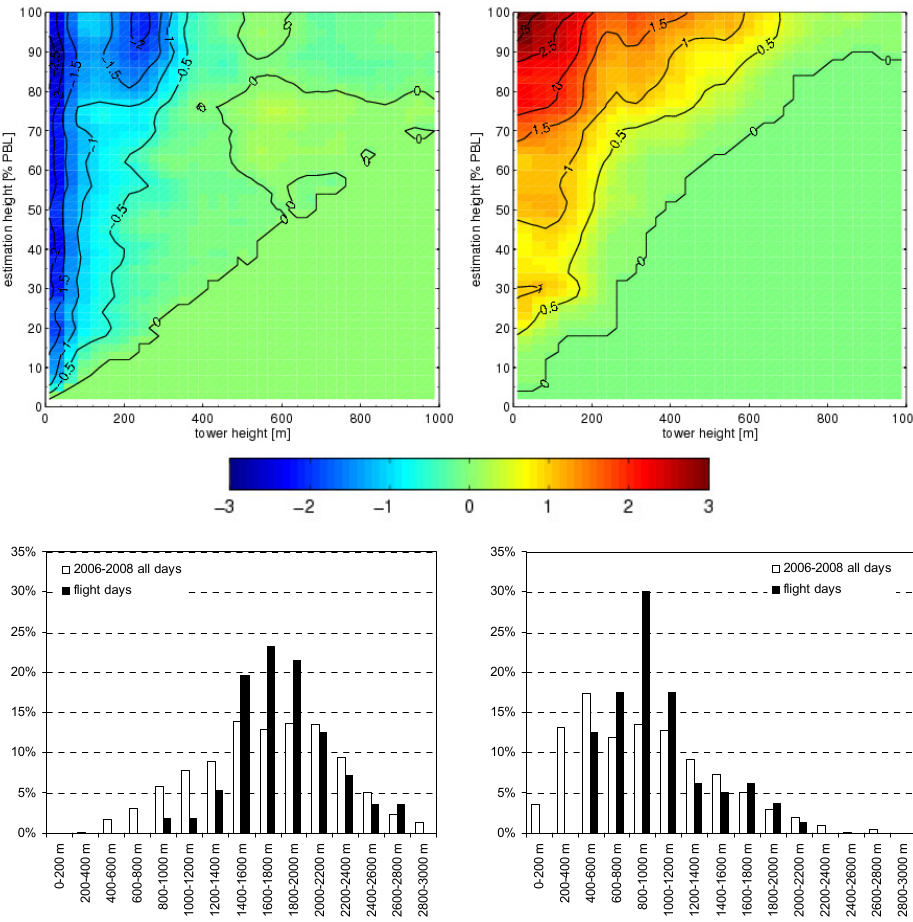
Figure 1. The median bias between the true CO 2 mole fraction and the estimated one as a function of the height of the hypothetical tower (tower height) simulated by the aircraft or the existing tower and the relative height within the PBL for which the mole fraction is extrapolated (estimation height) from the measurements at the top of the hypothetical tower (µmolmol − 1 ) . A negative sign means underestimation by the measurements. Left: summer; right: winter. Bottom panels show the 12:00UTC PBL-height statistics for all days during the period of 2006–2008 and for the days of the